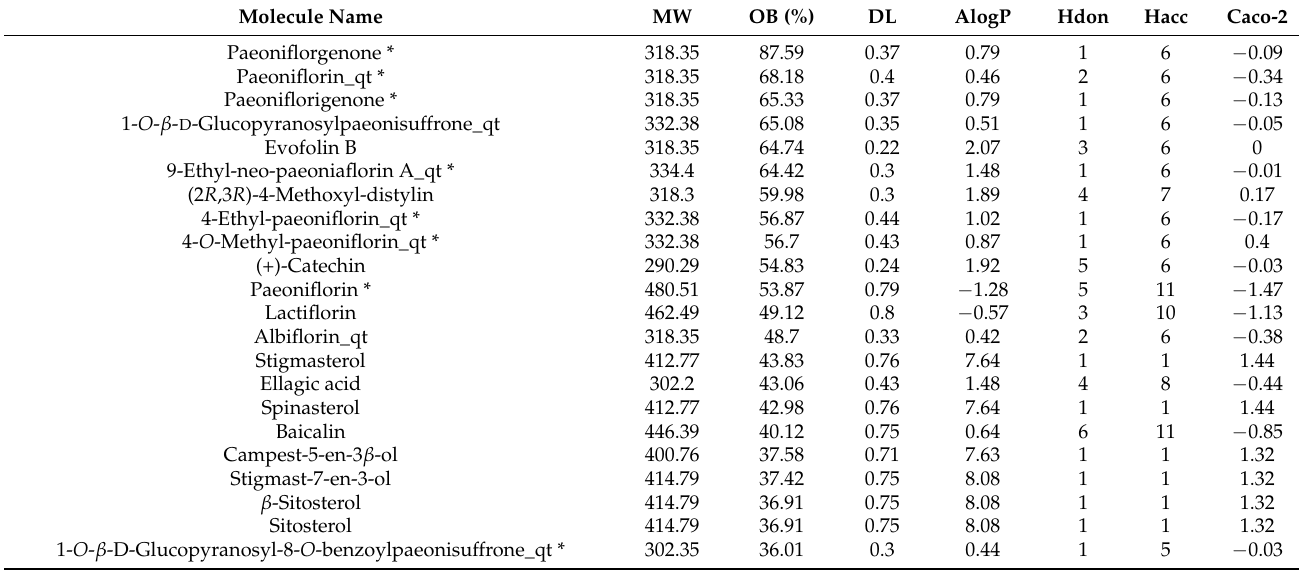
Figure 1. Paeoniflorin is the most active component of Paeonia lactiflora in improving endometrial receptivity. ( A ) Structures of major components of P. lactiflora . ( B ) Ishikawa cells were treated with indicated six compounds for 24 h and then harvested for Western blot analysis. The expression level of leukemia inhibitory factor (LIF) was used for screening. Table 1. Twenty-nine components of Paeonia lactiflora satisfied oral bioavailability (OB) ≥ 30% and drug likeness (DL) ≥ 0.18 obtained from Traditional Chinese Medicine Systems Pharmacology